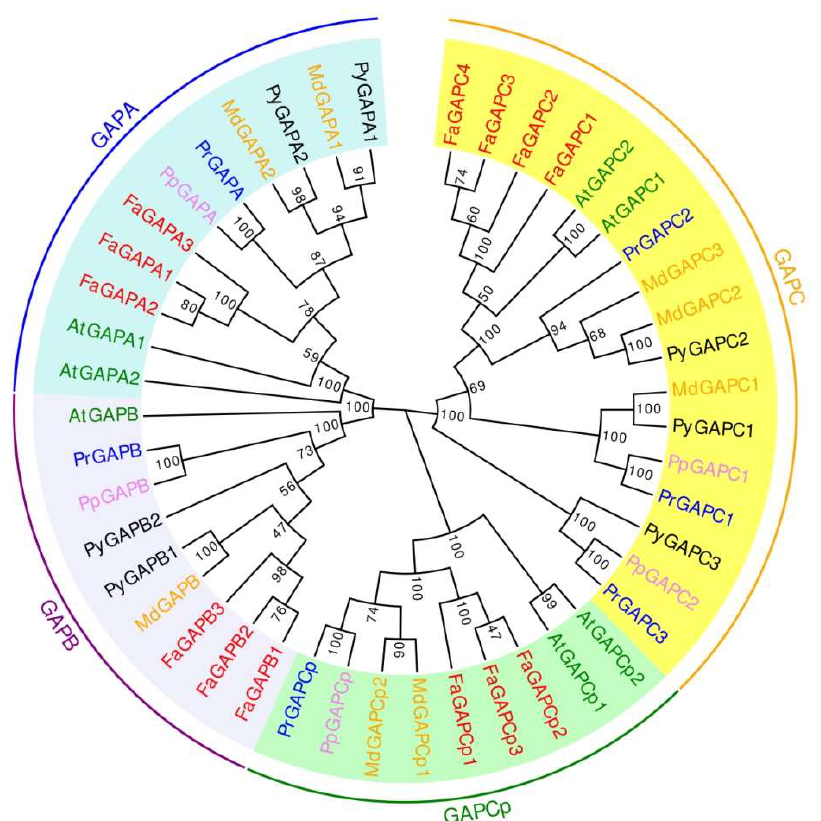
Figure 1. Phylogenetic analyses of glyceraldehyde-3-phosphate dehydrogenase ( GAPDH) and its homologs. A neighbor-joining phylogenetic tree was constructed based on the amino acid sequence of GAPDH and its homologs from Frugaria ananassa , Arabidopsis , and several other species. Gene IDs were listed as: AtGAPA1 (AT3G04120), AtGAPA2 (AT1G12900), AtGAPB (AT1G42970), AtGAPC1 (AT3G04120), AtGAPC2 (AT1G13440), AtGAPCp1 (AT1G79530), AtGAPCp2 (AT1G16300),